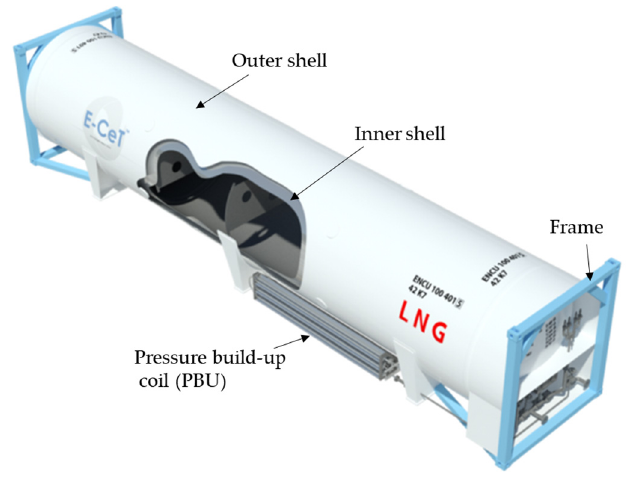
Figure 1. 40 ft LNG ISO tank.